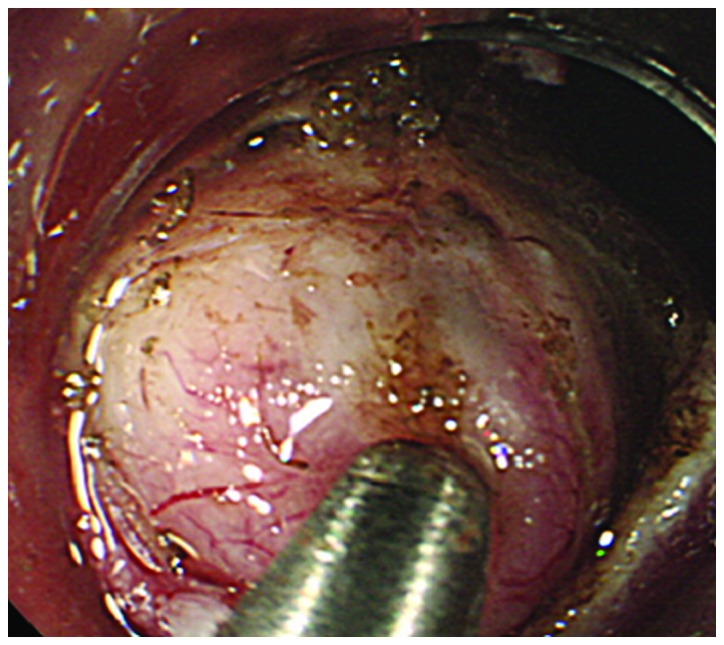
Typical endoscopically visualized feature (EVF) findings of submucosal tumors, with regard to rigidity. This GIST was rigid; it did not indent when compressed with a scalpel (case 9).